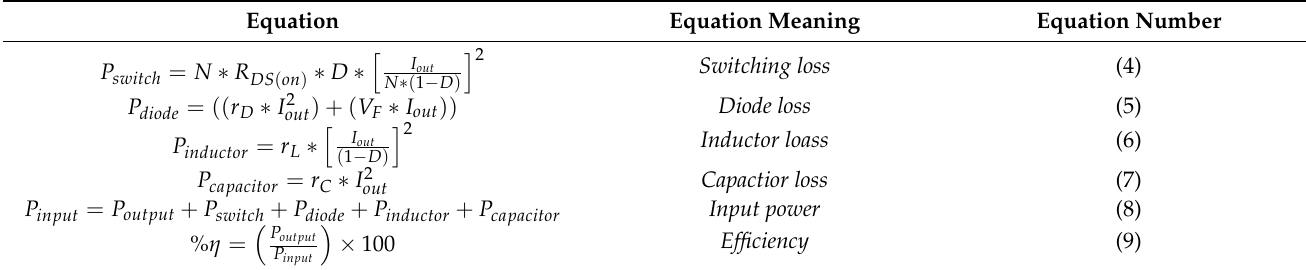
Table 4. Loss estimation equation for MPIBC.